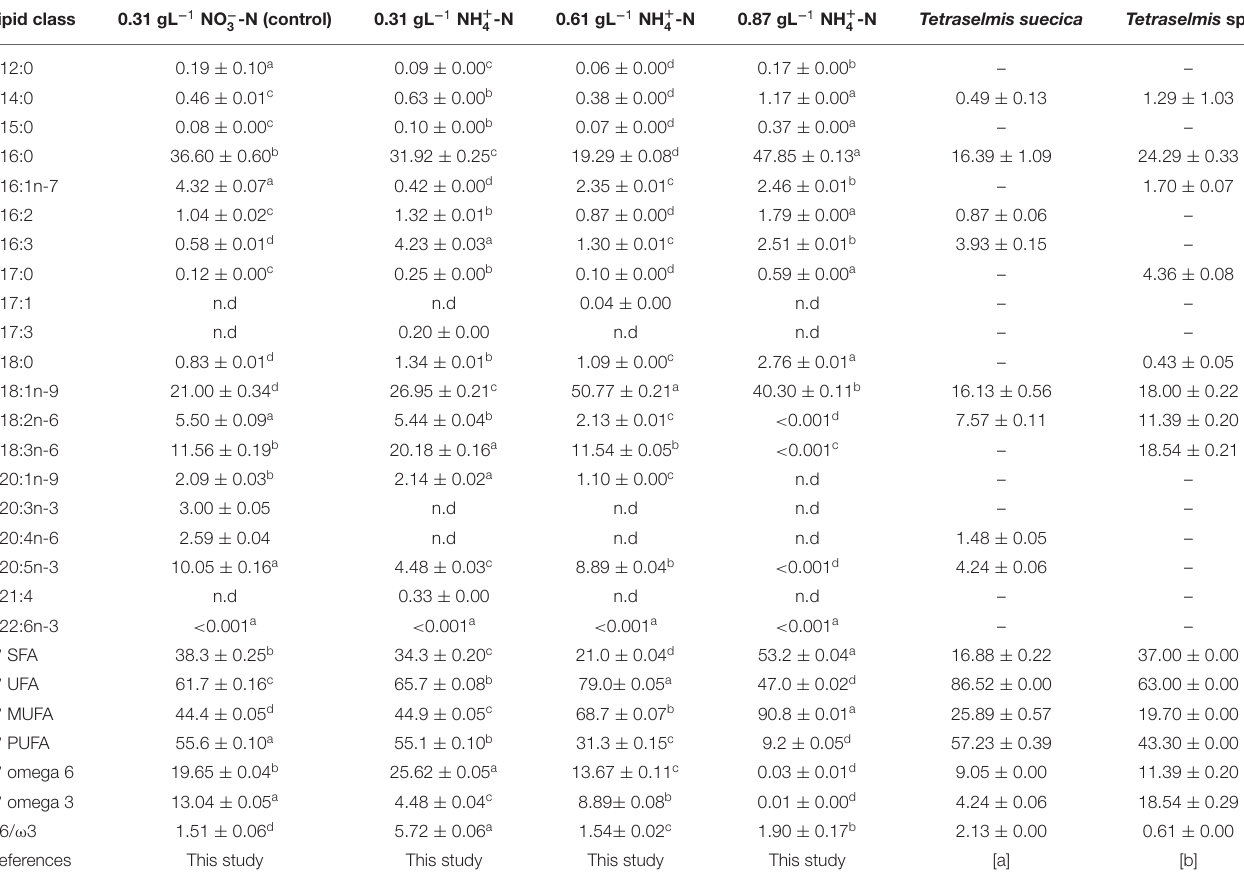
TABLE 2 | Fatty acid composition (% of total fatty acids) of Tetraselmis tetrathele grown at day 6 in different concentration of nitrogen sources and review on two marine microalgae species. Lipid